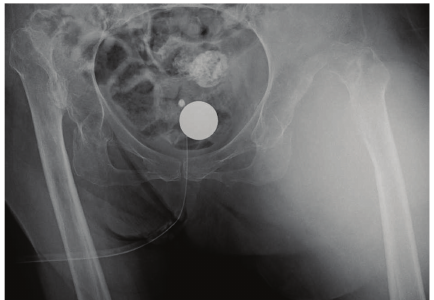
Figure 1: Radiograph taken at admission.